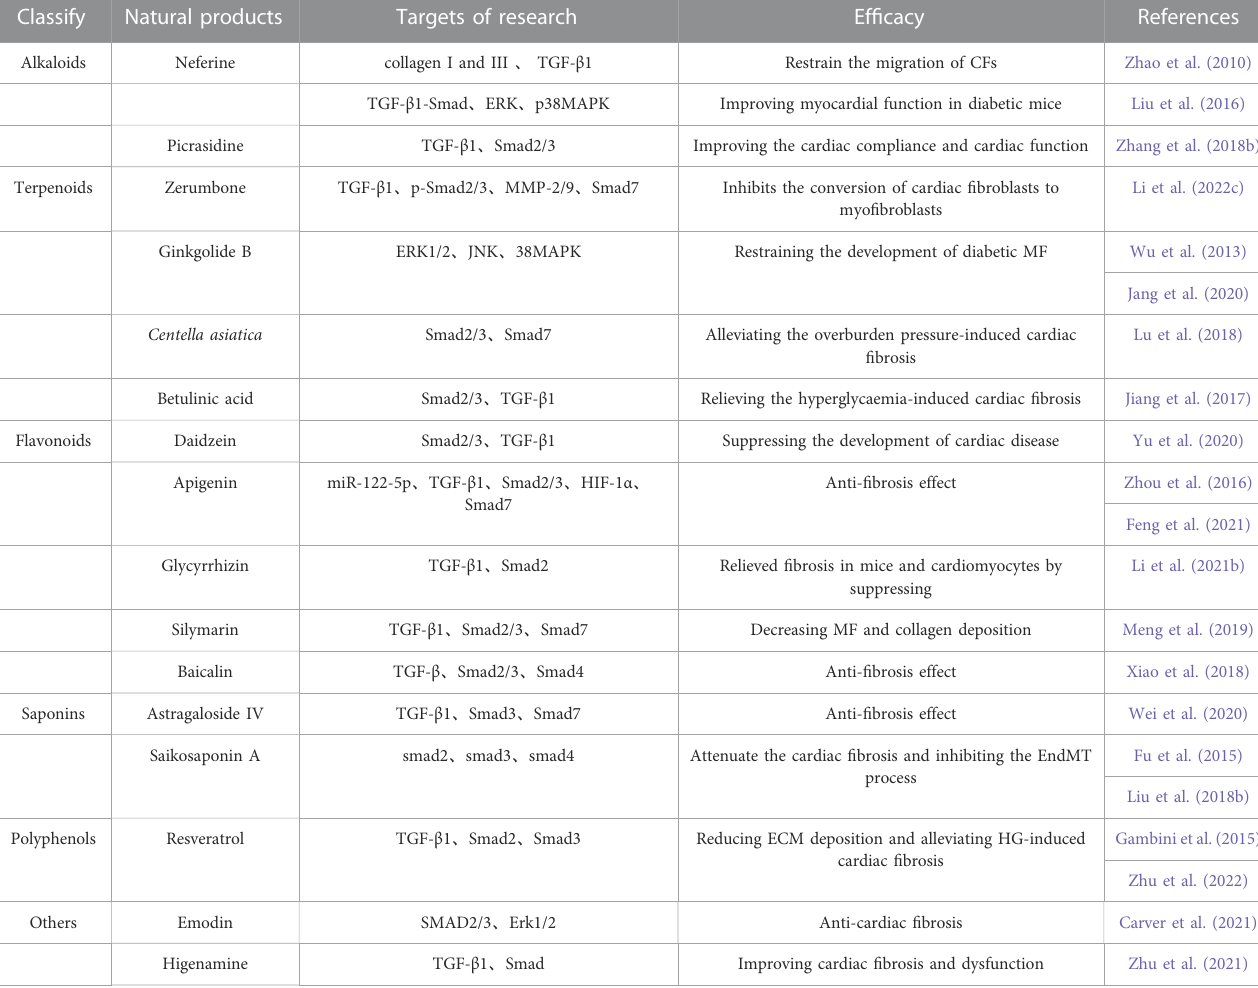
TABLE 4 Mechanism of Chinese herbal extracts or natural compounds interfering with cardiac fi brosis by regulating TGF-signaling pathway.